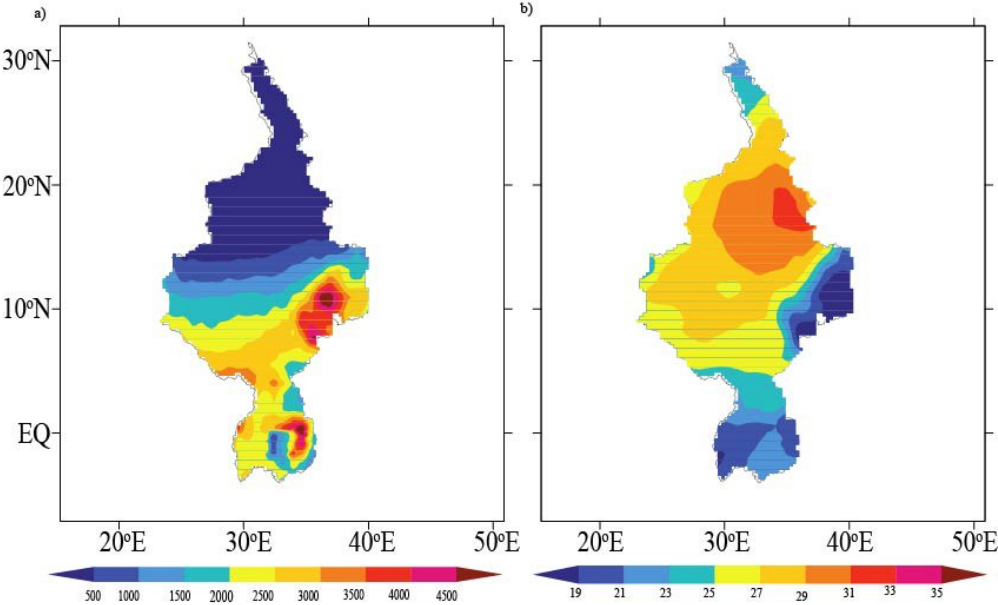
Figure A1. Nile Basin: ( a ) Mean Precipitation for the Nile based on European Center for Medium-Range Weather Forecasts (ECMWF) reanalysis (ERA-40) estimates ( b ) Annual mean Temperature distribution over the Nile River Basin based on European Center for Medium-Range Weather Forecasts (ECMWF) reanalysis (ERA-40) estimates.